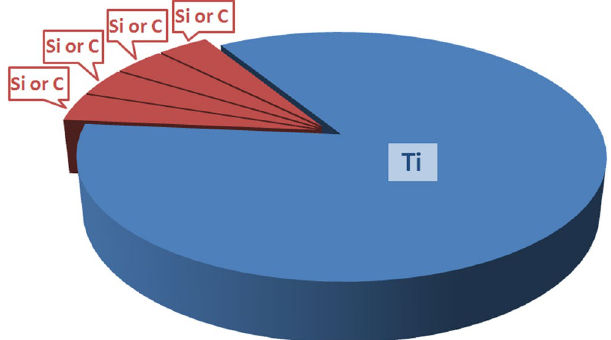
Figure 7. Schematic illustration of the TiSiC compound target used in the investigation. Through replacing different pieces of Si and C, the TiSiC compound targets with different Ti:Si:C volume or area ratios, including 21:4:0, 21:3:1, 21:2:2, 21:1:3 and 21:0:4, were